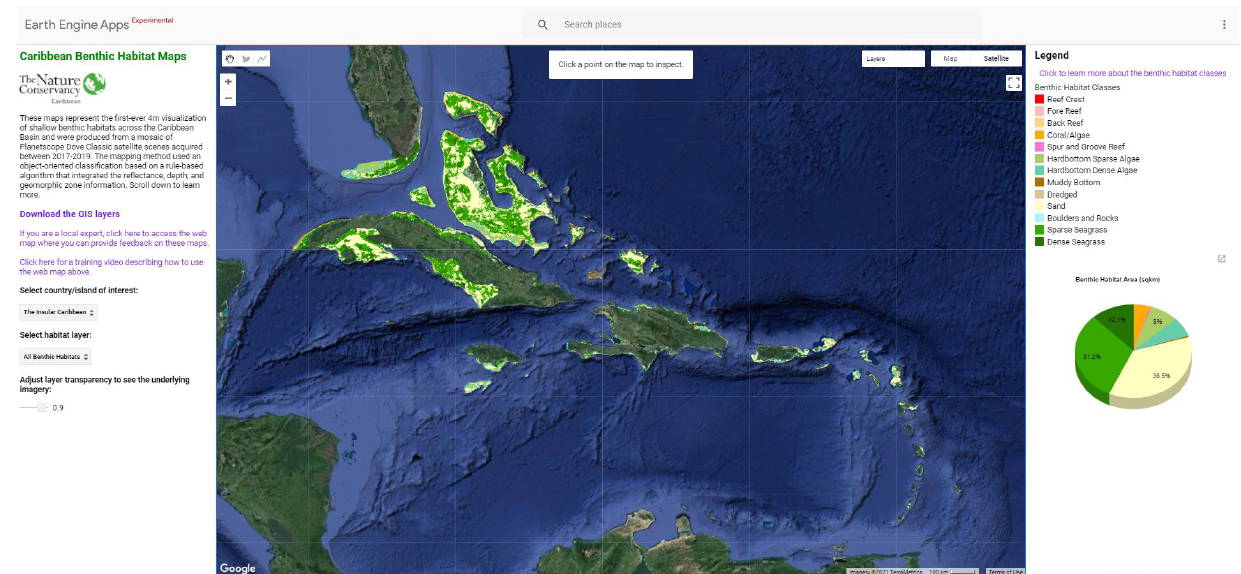
Figure 15. Final classification for 203,676 km 2 of shallow benthic habitat across the Insular Caribbean. These data are hosted at an online data portal found at CaribbeanMarineMaps.tnc.org (accessed on 19 October 2021), where data can be viewed and downloaded for advancing conservation actions throughout the